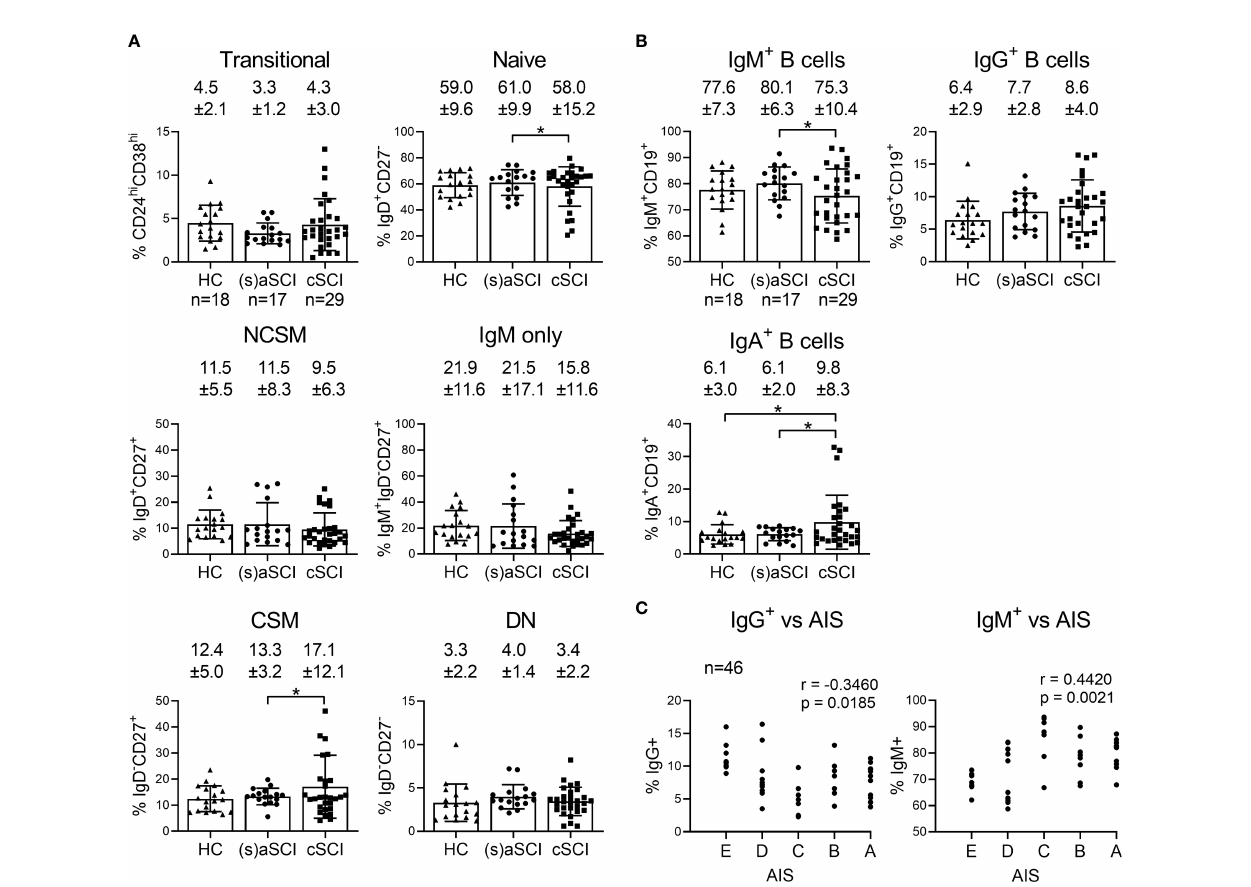
FIGURE 5 | Frequency of B cell subsets in the peripheral blood of HC and SCI patients. Percentages of the major B cell subsets (A) and IgM/G/A expressing B cells (B) are shown within the lymphocyte population of HC (n = 18) and SCI patients (n = 18), including (s)aSCI (17 samples) and cSCI (29 samples). Mean (bars) ± SD is depicted and shown in numbers. (C) Correlation of the IgG + or IgM + B cell frequency and AIS score at sampling timepoint. r denotes the Spearman correlation coef fi cient (rho). Numbers of included samples in each group are also indicated in the fi rst graph of each fi gure panel. *p <